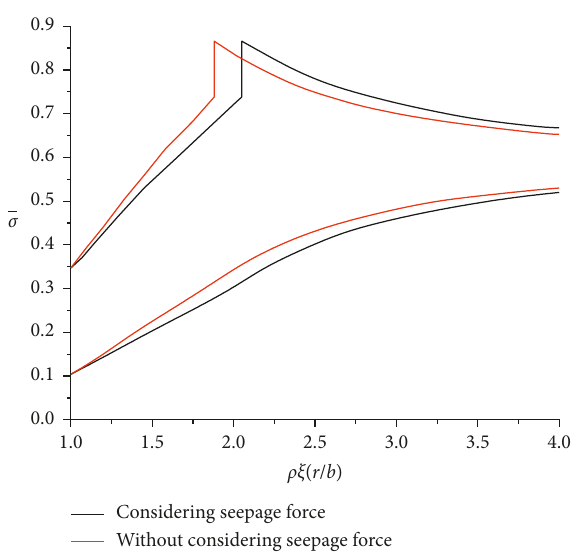
Figure 22: Variation of the dimensionless radial and circumfer- ential stresses considering seepage force with the change of c p the generalized Hoek–Brown rock mass.